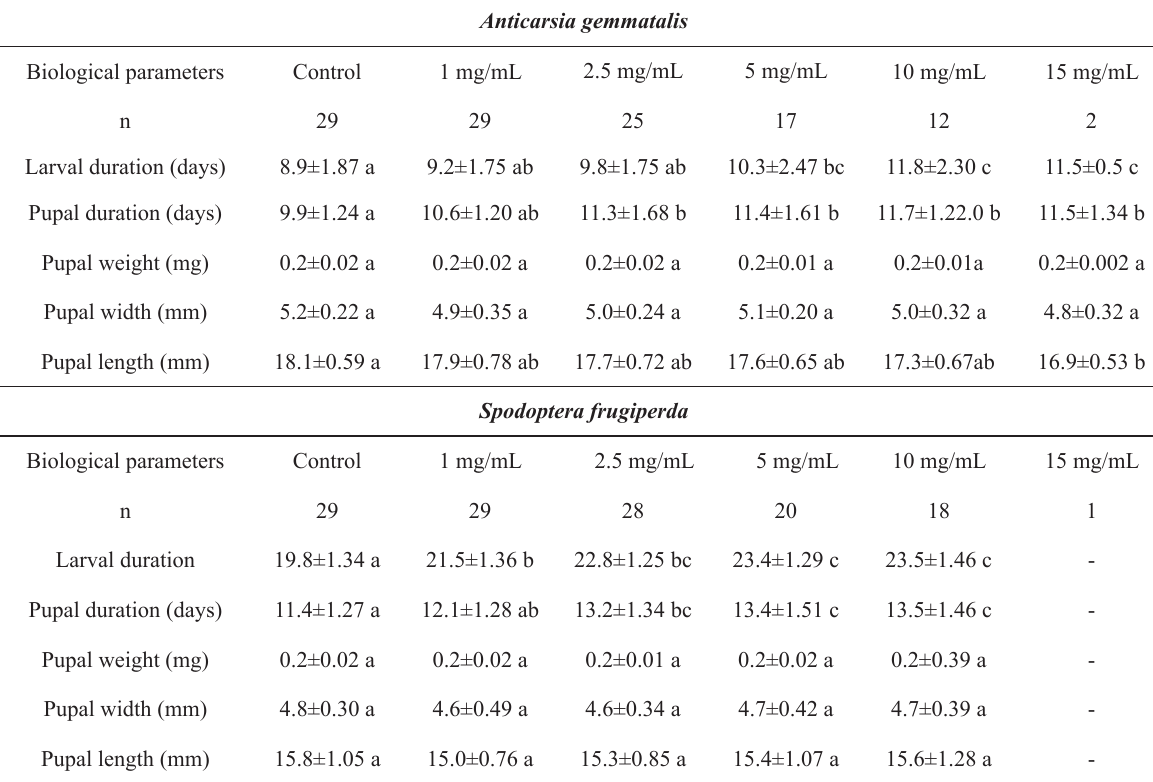
Biological parameters of Anticarsia gemmatalis and Spodoptera frugiperda fed artificial diet containing the hexane extract of Piper aduncum leaves . Anticarsia